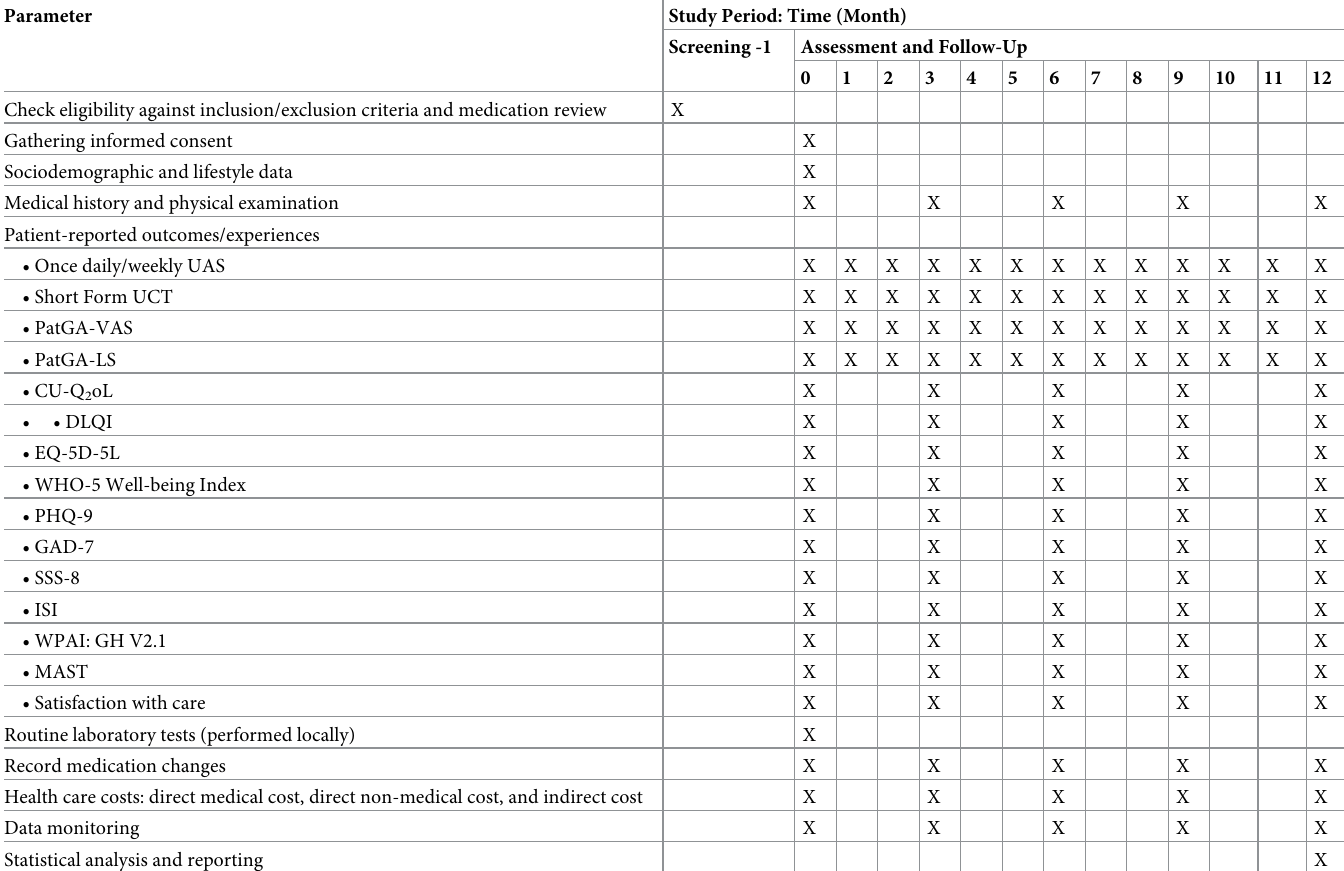
Table 3. Schedule of observation and